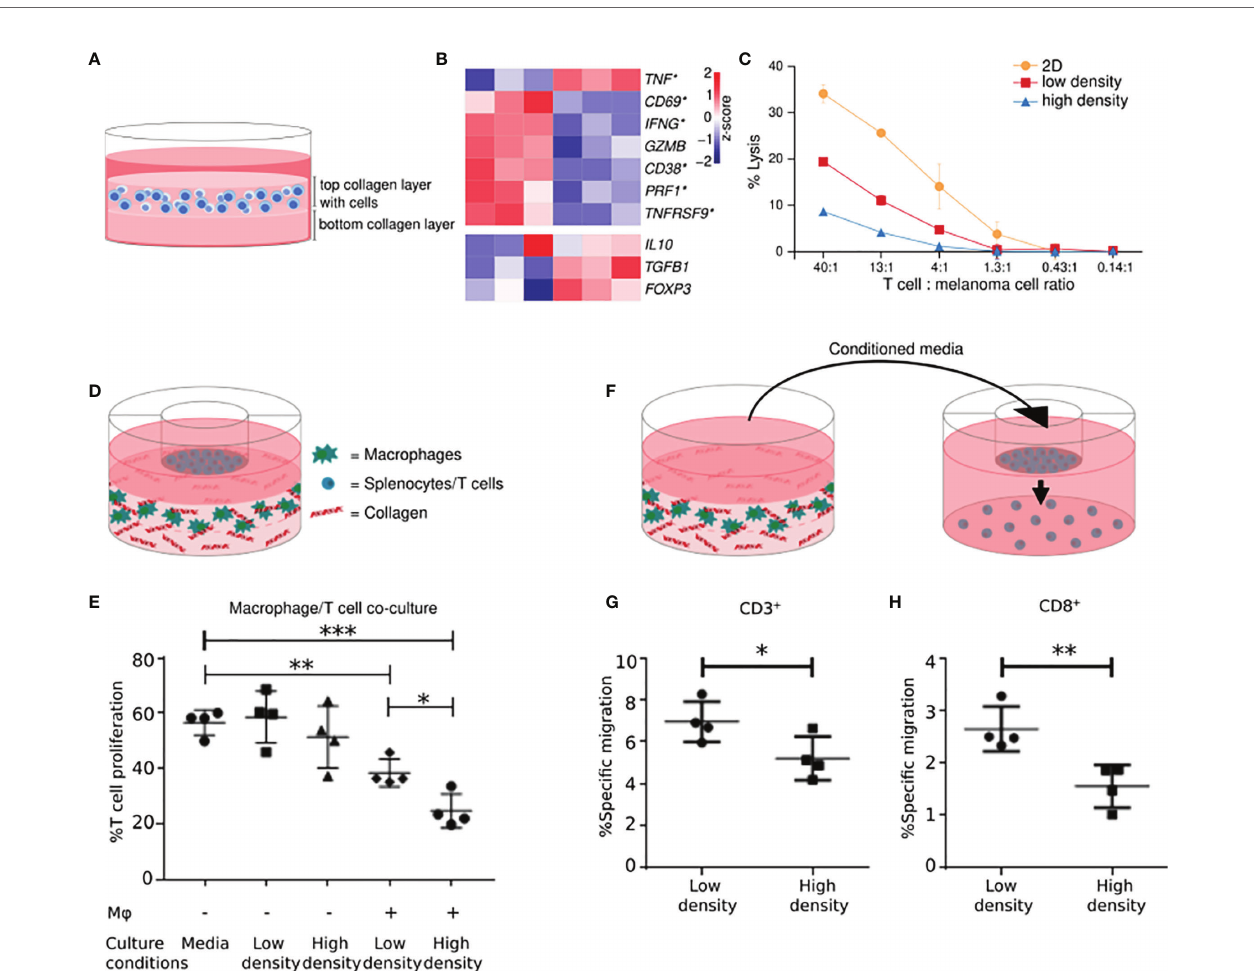
FIGURE 1 | A high collagen density inhibits T cell activity and stimulates the immunosuppressive activity of macrophages. High-density collagen affects T cell activity. (A) T cells were transiently stimulated with PMA and ionomycin and subsequently embedded and cultured in a collagen matrix of high (4 mg/ml) or low density (1 mg/ml). (B) T cells were cultured in high-density- or low-density collagen matrices for 2 days and their gene expression pro fi les analyzed. Heatmaps of normalized (Z-score) RNAseq read counts of genes encoding markers of T cell activity (top panel) and Tregs (bottom panel). Signi fi cantly regulated genes indicated with asterisks. 6 out of 7 markers of T cell activity were signi fi cantly downregulated by high-density collagen culture. A trend towards an upregulation of Treg markers was observed. (C) Tumor in fi ltrating T cells were cultured for 3 days on plastic (2D) or in 3D high- or low-density collagen matrices. T cells were extracted and incubated for 4 hours with autologous melanoma cells in different ratios of T cells: melanoma cells. Lysis of melanoma cells by T cells was analyzed using a 51 Cr- release assay, with addition of 10% Triton X-100 used for determining maximum lysis (100%). The cytotoxic activity of T cells was impaired by 3D culture, in particular high-density collagen culture. (D) RAW 264.7 macrophages were embedded and cultured in a collagen matrix of high- or low density. Splenocytes isolated from BALB/c mice were seeded in transwell inserts on top. After 3 days, T cell proliferation was analyzed using a BrdU-based fl ow cytometry assay. (E) Proliferation of T cells was decreased when co-cultured with macrophages compared to T cells cultured alone. The proliferation was further decreased when co-cultured with macrophages grown in high-density collagen compared to low-density collagen. (F) T cells were seeded in transwell inserts above conditioned medium from macrophages cultured for 3 days in high- or low-density collagen matrices. T cells were allowed to migrate towards the conditioned medium for 26-28 hours, and migrated cells were analyzed with fl ow cytometry. (G, H) T cells migrated signi fi cantly less towards conditioned medium from macrophages from high-density collagen matrices. The reduced migration was observed for CD3 + T cells (G) and for CD8 + T cells (H) . *P < 0.05; **P < 0.01; ***P < 0.001. (A – C) were adapted from (85). (D – H) were adapted from (86) with permission from The American Association of Immunologists, Inc